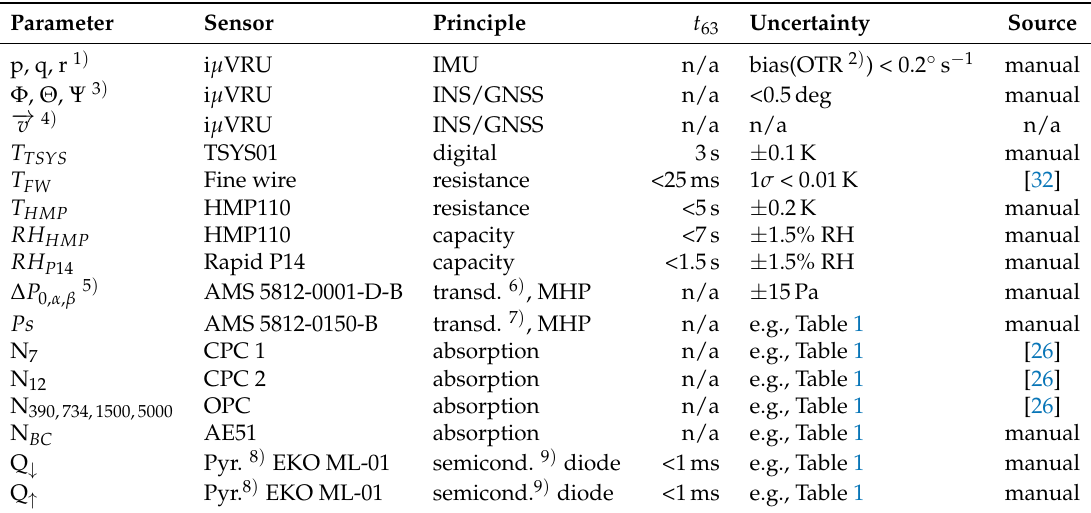
Table 2. Table of sensors installed in the UAS ALADINA. OPC, optical particle